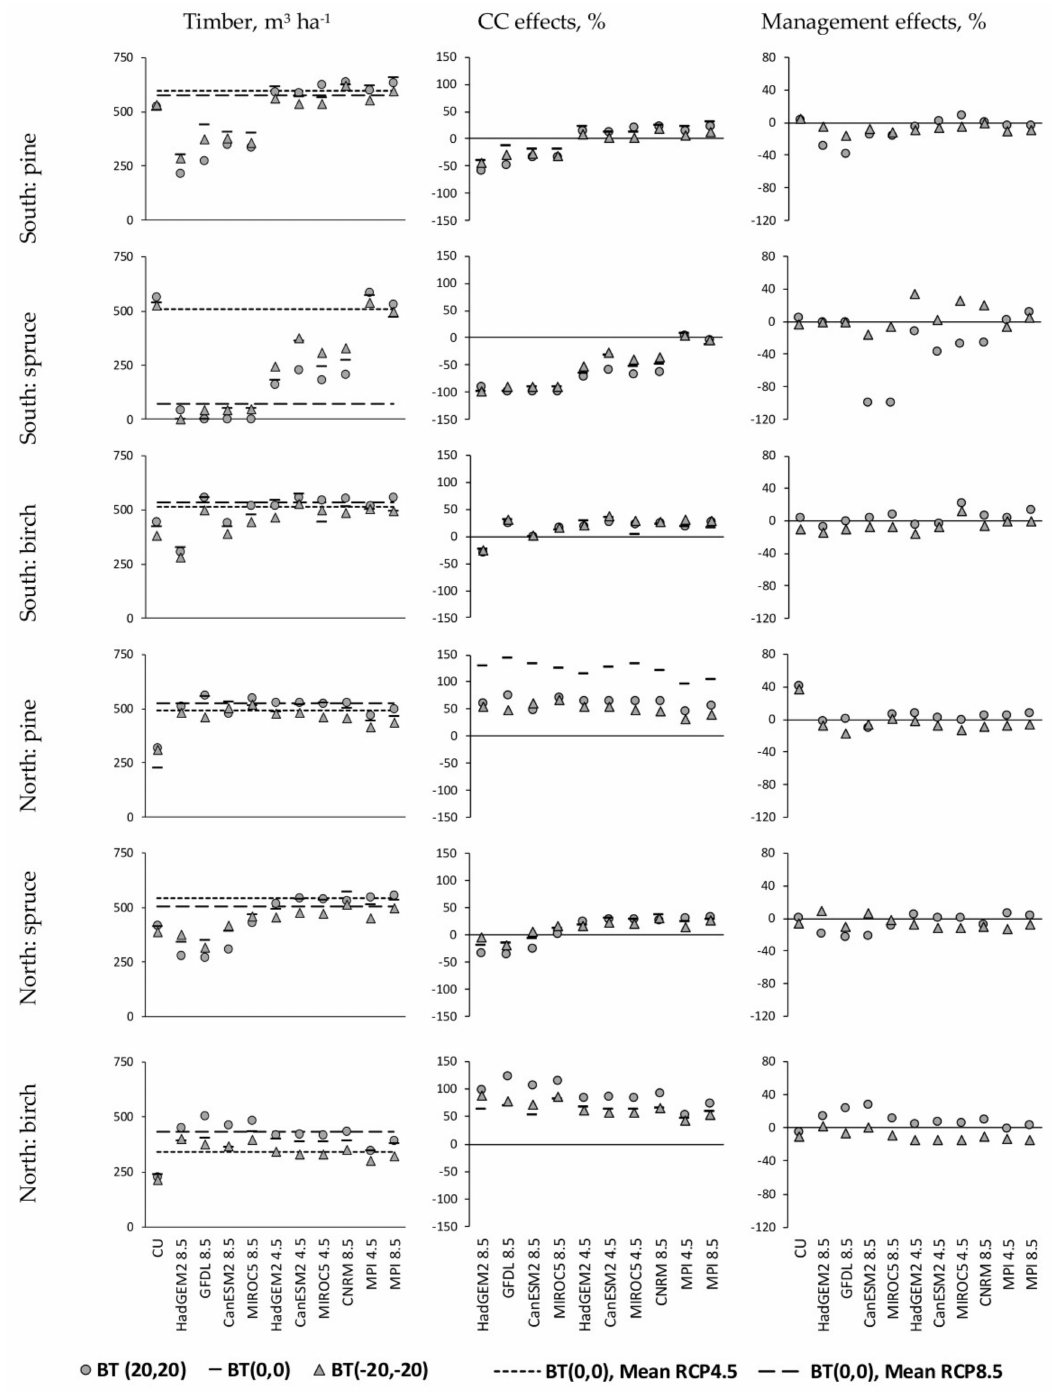
Figure 4. The timber yield (m 3 ha − 1 ) in Scots pine, Norway spruce and Silver birch stands with different management regimes under the current climate (CU) and individual GCM projections (shown in table 2), under the RCP4.5 and RCP8.5 forcing scenarios, in southern and northern Finland. As a comparison, also absolute values (on the left) for the multi-model means of the GCMs under the RCP4.5 (Mean RCP4.5) and RCP8.5 (Mean RCP8.5) forcing scenarios are